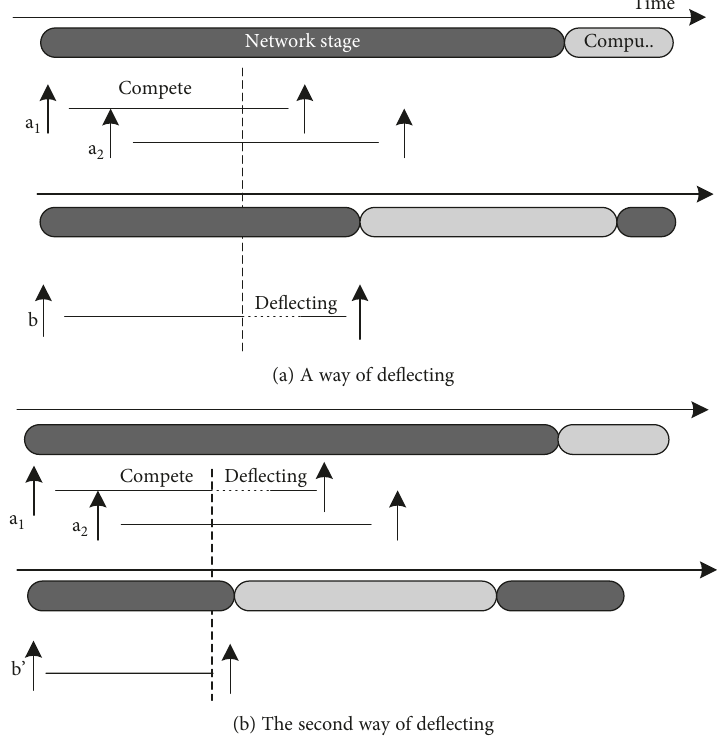
Figure 7: The e ff ect of de fl ection from di ff erent